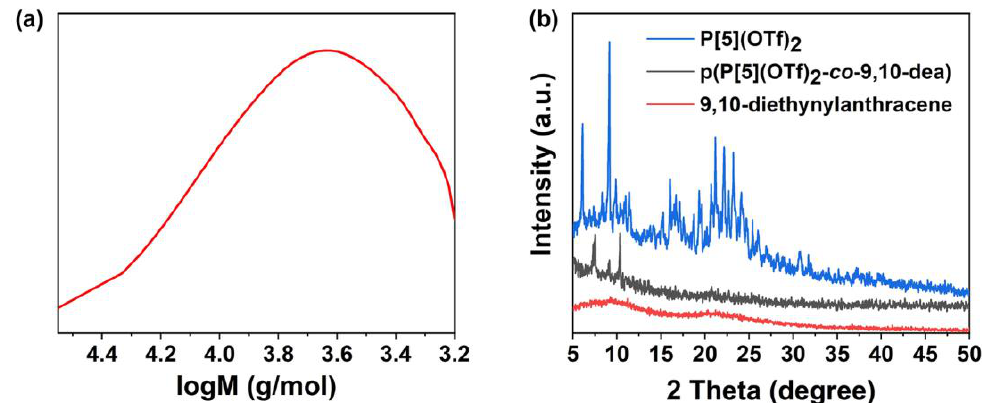
Figure 1. ( a ) GPC trace of p(P[5](OTf) 2 - co -9,10-dea). ( b ) XRD patterns of P[5](OTf) 2 (blue), p(P[5](OTf) 2 - co -9,10-dea) (black), and 9,10-diethynylanthracene (red).